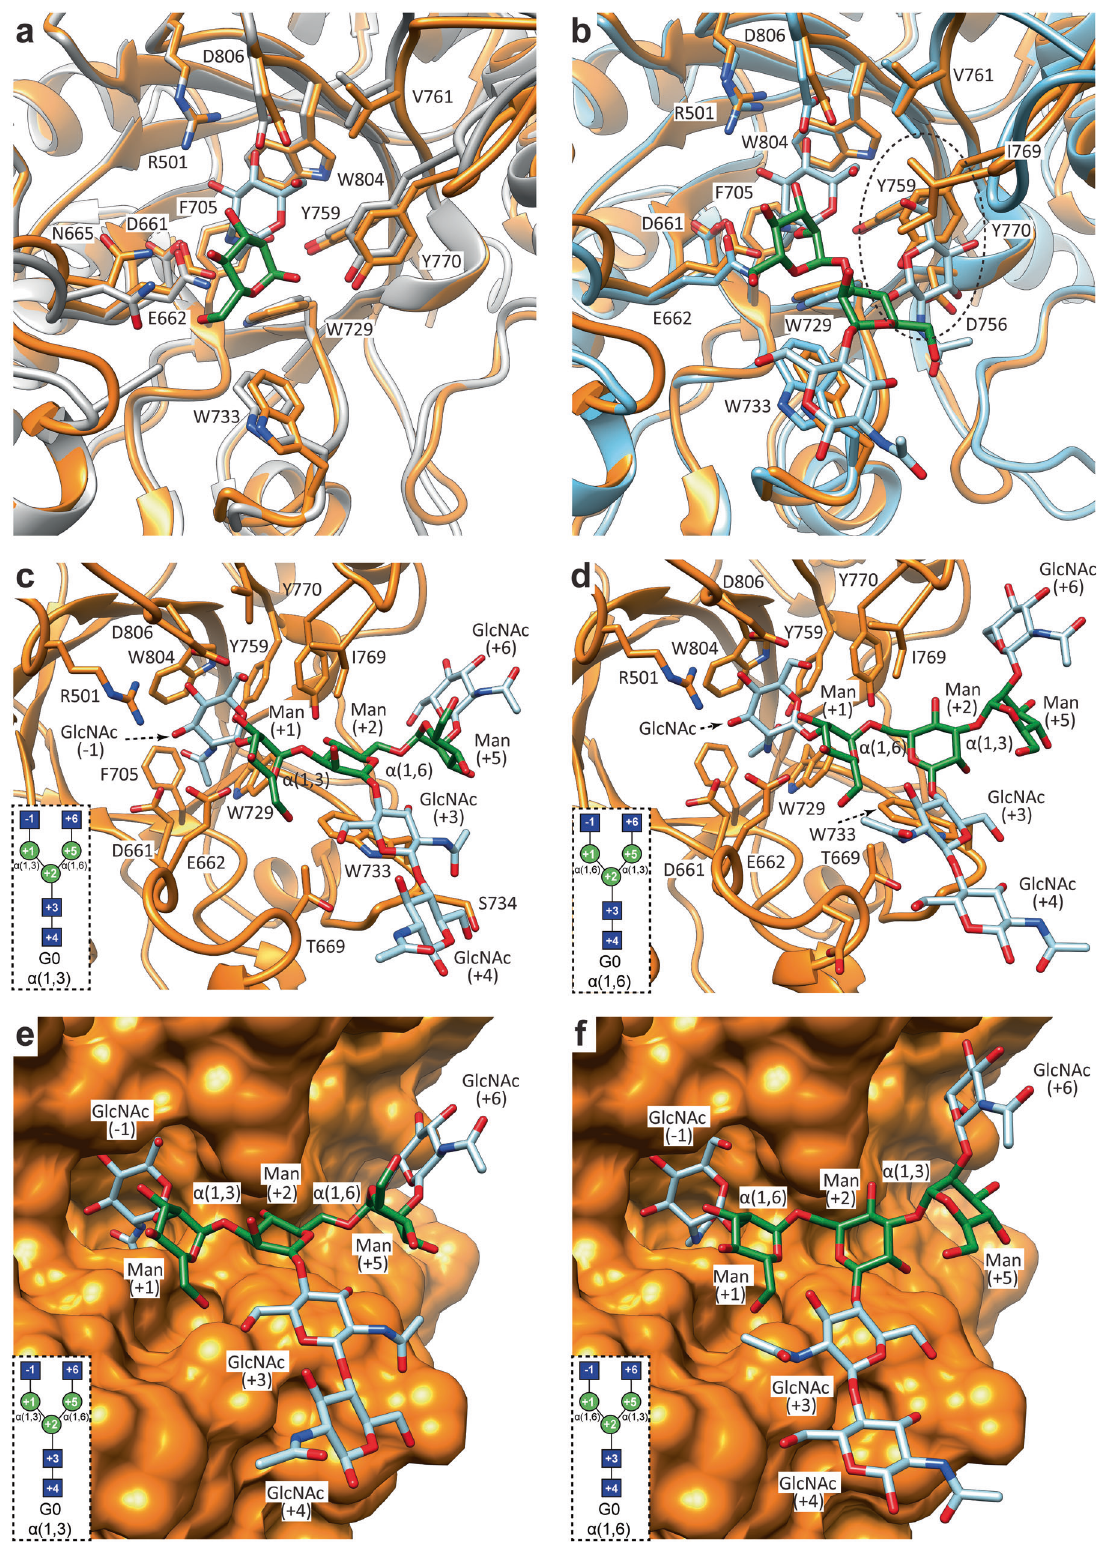
clearly shows that both EndoE and EndoE-GH18L, but not EndoE-GH20, cleave HM-type N -glycans on RNAse B (Supple- mentary Fig. 5). Moreover, our LC-MS analysis for EndoE- GH18L with RNAse B indicates that this domain hydrolyzes the Man 5 glycoform and, at a slower rate, the Man 6 glycoform. EndoE-GH18L appears to be inactive on RNAse B bearing